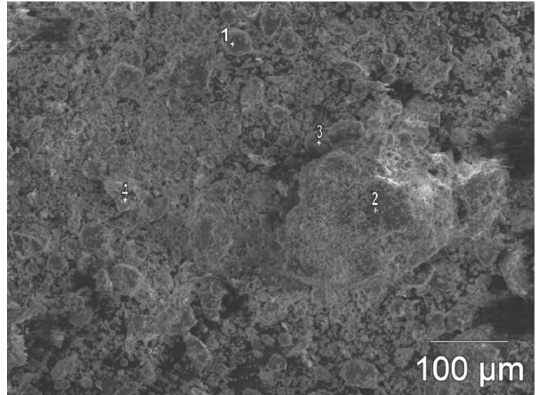
Figure 4. SEM image of ODFA; points 1–4 represent selected points for EDS analysis.